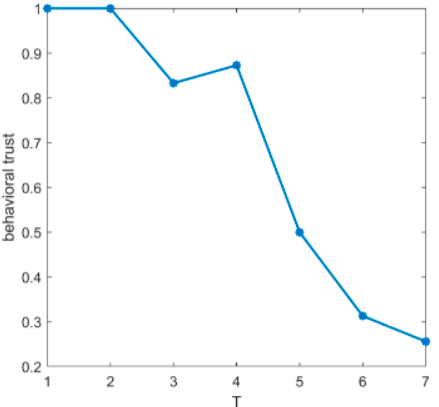
Figure 2. The behavioral trust of AS 2